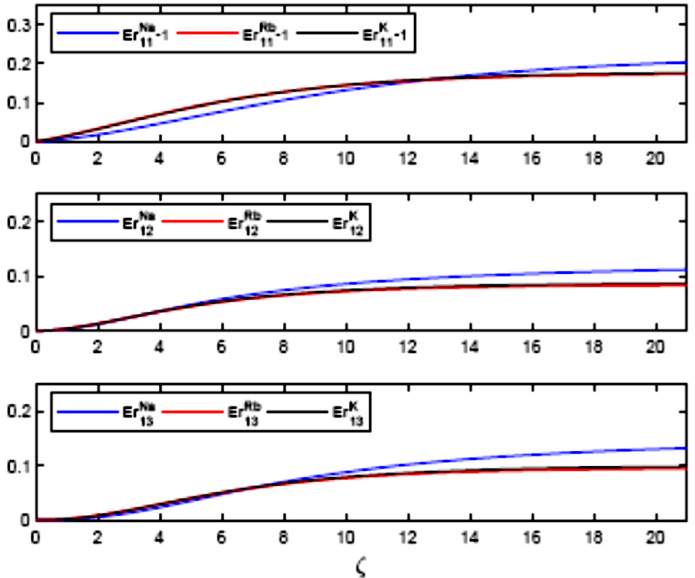
Figure 4. Amplification of the relative energies for drive pulses in different alkali vapours. Energies E 11 , E 12 , and E 13 for probe and drive fields to correspond to time sections τ = [0, 85], τ = [85, 170], and τ = [170, 250], respectively. We have subtracted one from the energy of the first drive component to show the gain.